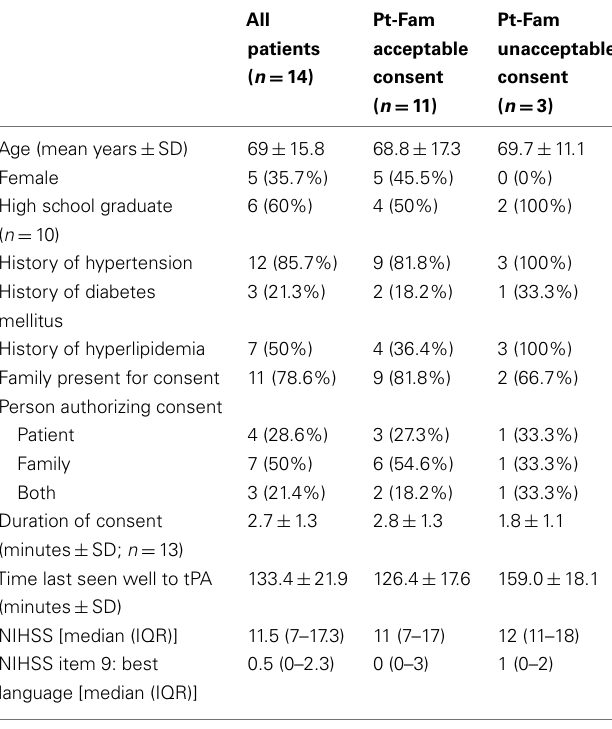
Table 1 | Patient characteristics for all patients and patients with acceptable vs. unacceptable patient/family consent.